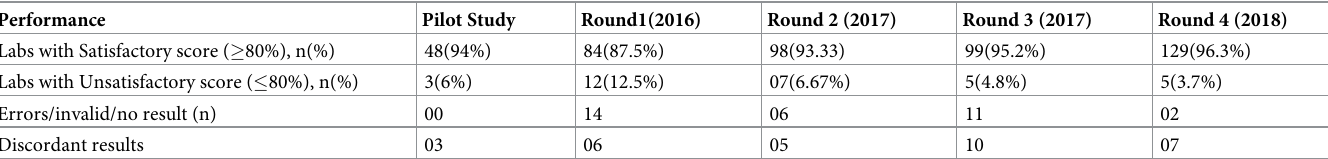
Table 2. Performance of participating sites throughout the different rounds.